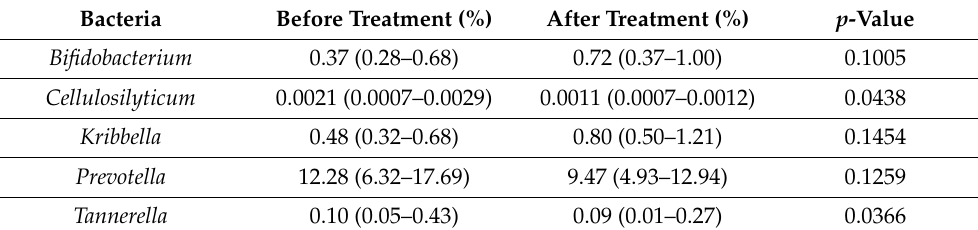
Table 2. Comparison of changes in relative abundance before and after the anticancer therapy. Bacteria Before Treatment (%) After Treatment (%) p -Value